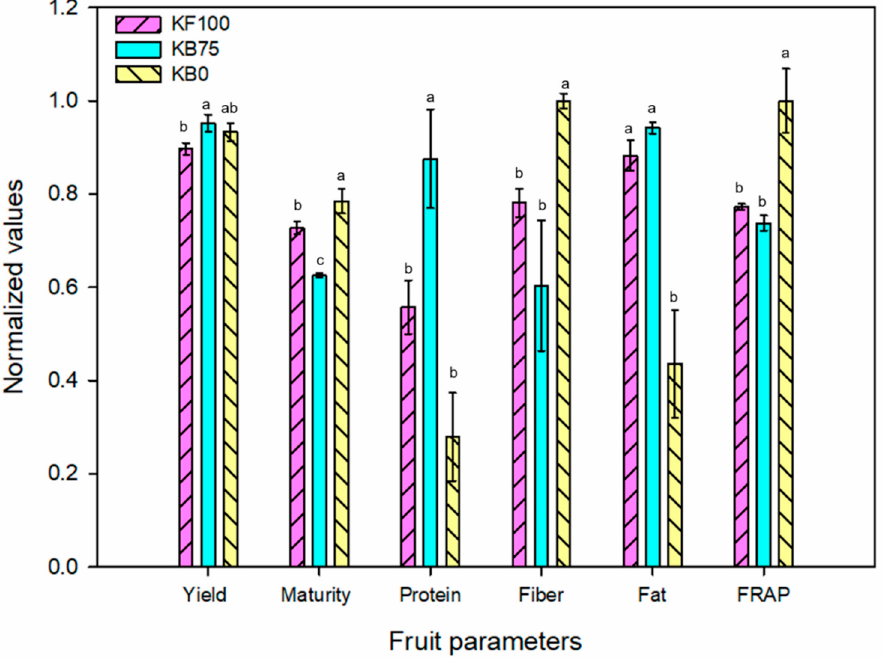
Figure 4. Comparison of the normalized main parameters indicating the quality of tomatillo fruits ( Physalis ixocarpa Brot. cv. “cáscara morada”) in the evaluation of the biofertilizing effect of Acinetobacter calcoaceticus UTMR2 for selected treatments at different doses of potassium. KF#: treatments with chemical fertilization only; KB#: treatments with chemical fertilization and biofertilization; #: potassium fertilization dose (%) based on the recommended dose for tomatillo cultivation [20]. Data normalization and mean comparisons were calculated considering all the treatments of the study. Different letters in the columns for each parameter indicate a significant difference among the treatments according to the HSD Tukey test ( p < 0.05, n = 3).